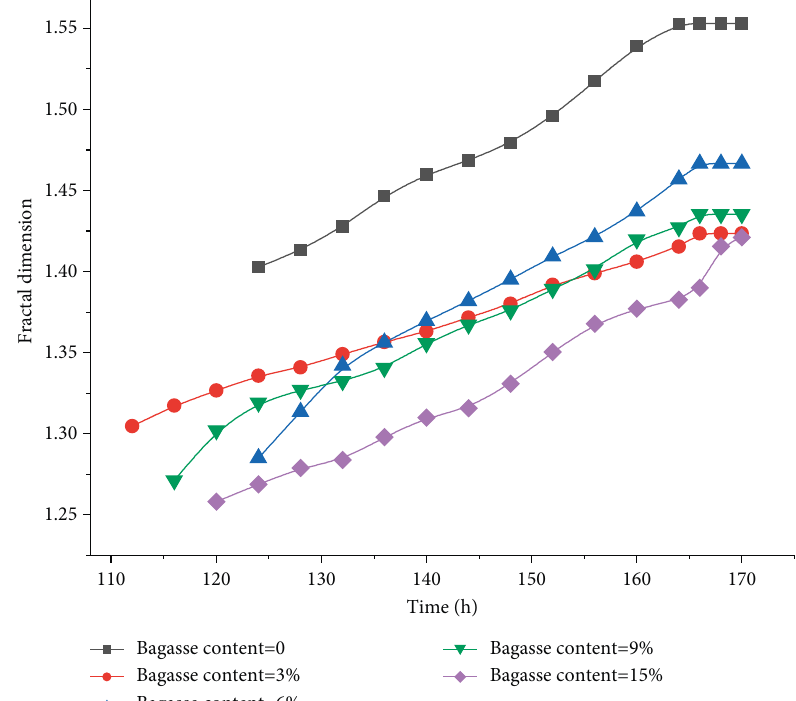
Figure 5: Change characteristics of clay crack fractal dimension with different bagasse content.